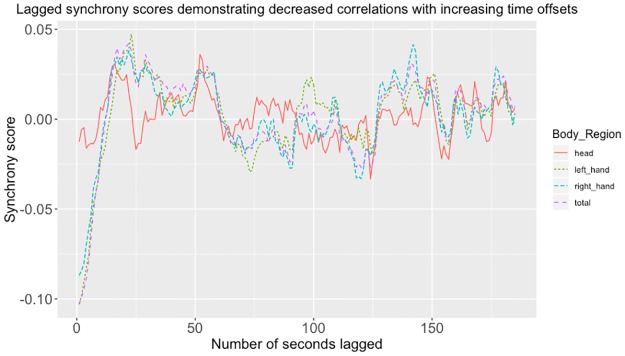
Lagged synchrony scores for different body regions.This figure shows the results of lagging participants’ movements as an alternate method of establishing synchrony. Head movements, hands movements, and total movements, each represented by one line. At time 1 on the X-axis, the Y-axis shows the average of the correlations between the first two 100-second segments of each participant’s movements. These correlations are then offset in two directions. Participant A’s movements were moved forward one second, such that their 100-second segment movement traces starting at time one are matched successively to Participant B’s 100-second segment movements starting at times two, three, etc., up to 185 seconds. This period of 185 seconds was chosen to maximize the number of eligible pairs. Because the length of each recording varied slightly, such that after 185 seconds some participant pairs were not recorded. The process was then reversed, such that Participant B’s movements were moved forward one second while Participant A’s remained stationary. We then averaged all the correlations at each lag; A on B, and B on A. The X-axis shows the amount of offset (averaged across both directions) at increasingly large amounts of time, from 0 seconds to 185 seconds. We see a strong negative Spearman’s: correlation at the beginning, which levels off at around 25 seconds offset.